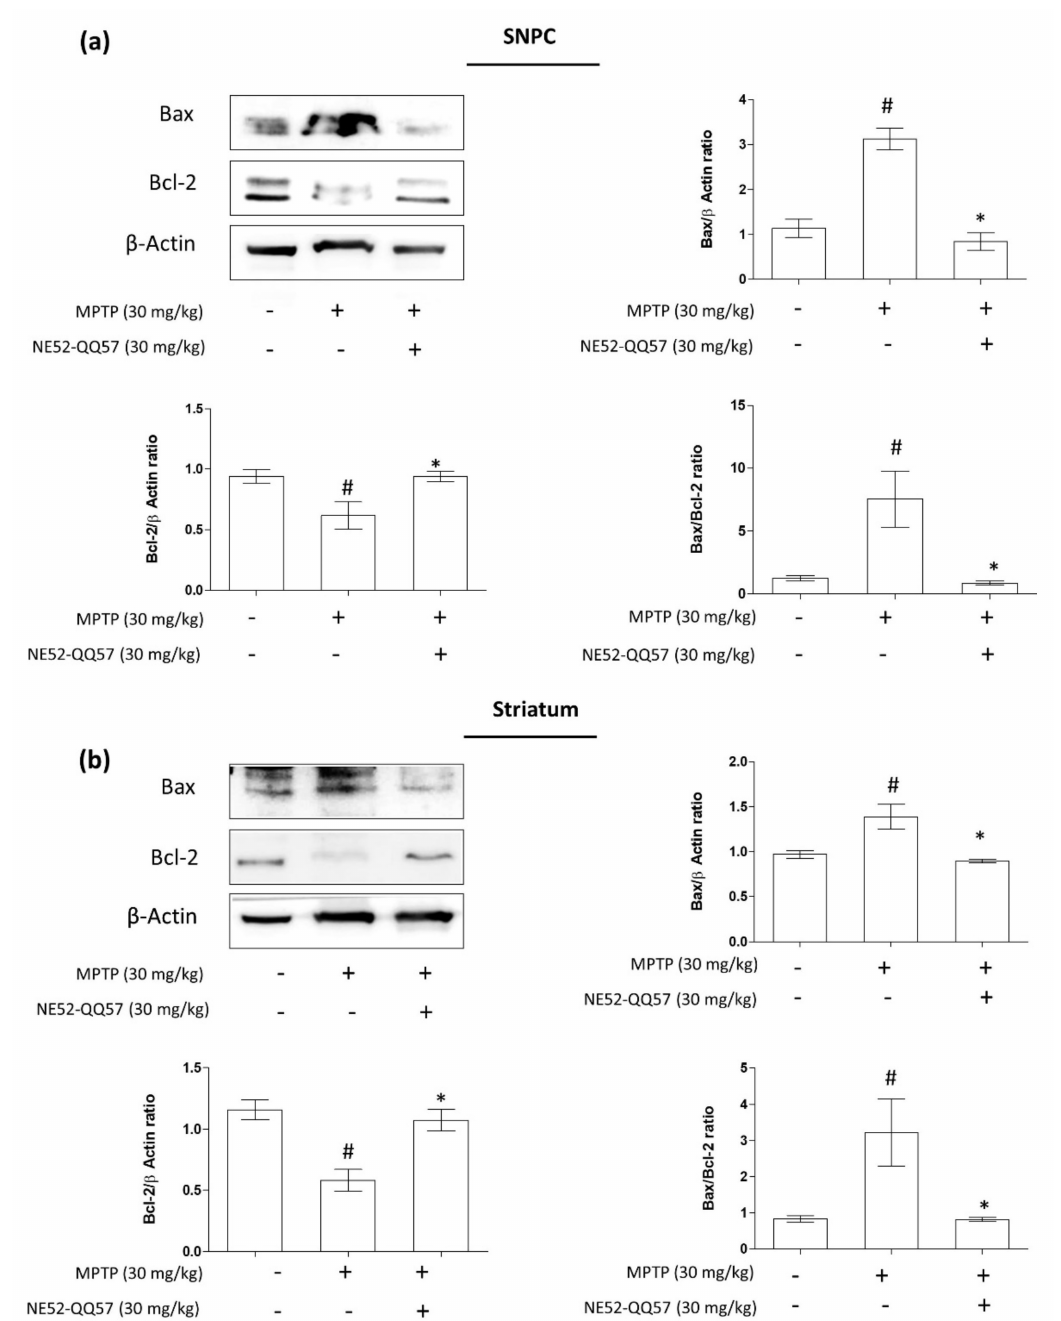
Figure 3. The effects of the GPR4 antagonist NE52-QQ57 on pro-apoptotic Bax and anti-apoptotic Bcl-2 protein expressions in MPTP-treated mice. MPTP was administered (30 mg/kg/day) for 5 days. Mice were sacrificed 3 days after the final MPTP injection, and the substantia nigra and striatum tissues were collected. ( a ) Bax and Bcl-2 protein expression in the SNpc region of the mouse brain ( n = 3) and densitometric analysis. ( b ) Bax and Bcl-2 protein expression in the striatum region of the mouse brain ( n = 3) and densitometric analysis. β -Actin was utilized as an internal control. Data are presented as the mean ± SEM. One-way ANOVA, followed by Tukey’s multiple comparison test, was used. # p < 0.05 when the MPTP-treated group was compared with the vehicle-only group; * p < 0.05 when other treated groups were compared with the MPTP-treated